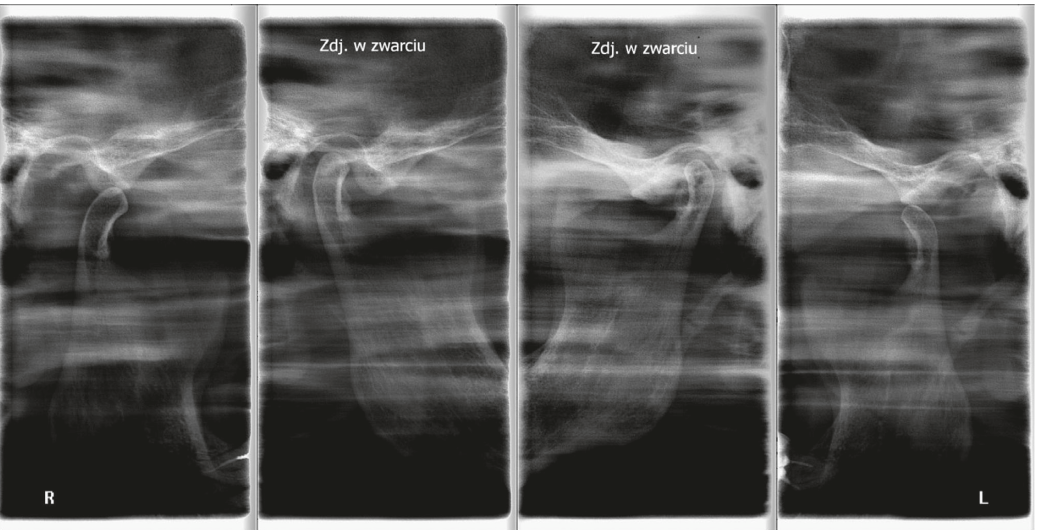
Figure 17: The radiographs of a nonconcentric condylar position: deficient vertical dimension (condylar position in occlusion—internal scans) and a muscle contracture in the right TMJ.